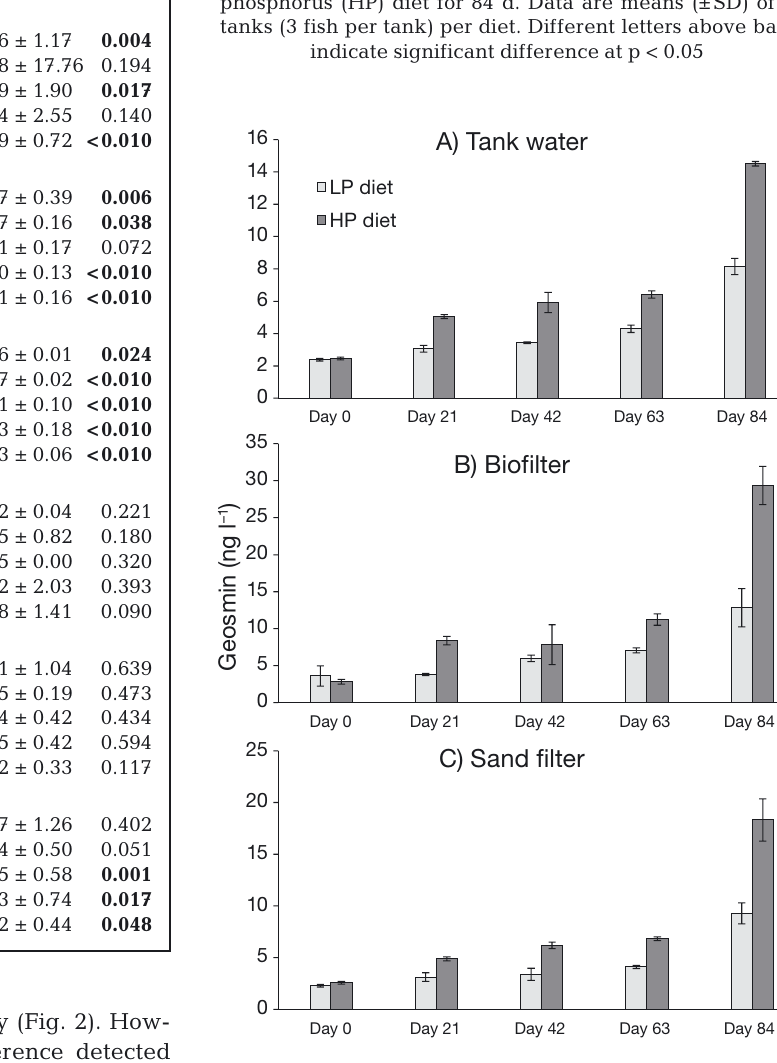
Fig. 3. Oncorhynchus mykiss . Changes in geosmin concen- tration in the (A) tank water, (B) biofilter and (C) sand filter of the tanks where fish received low-phosphorus (LP) and high-phosphorus (HP) diet for 84 d. Data are means (±SD) of 4 tanks per